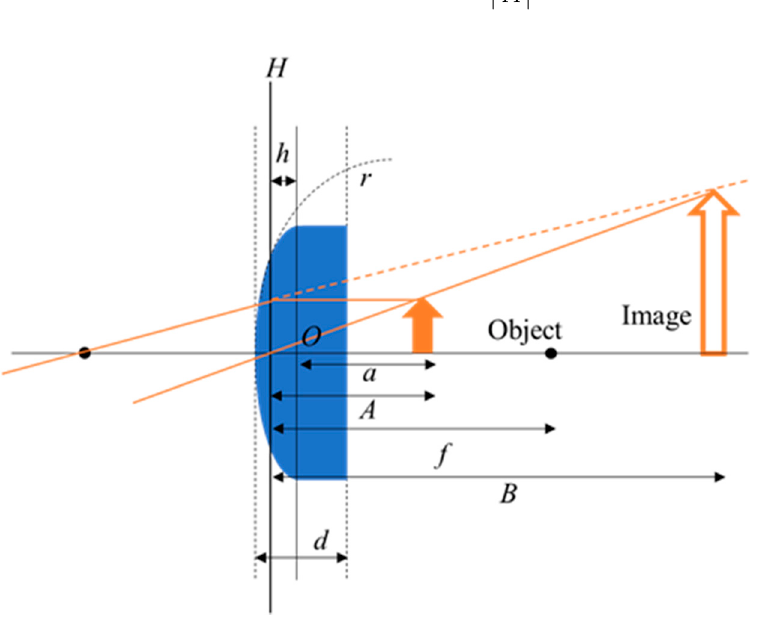
Figure 3. Model diagram of the plano-convex lens.